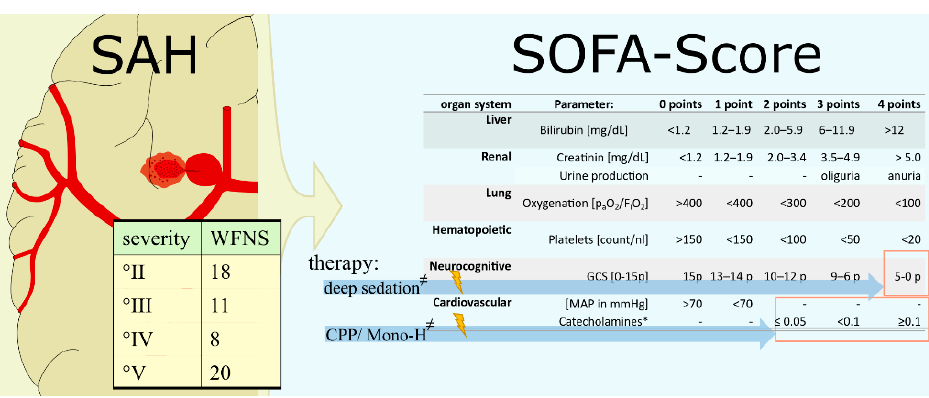
Figure 2. Severity of subarachnoid hemorrhage and influence of sepsis-related organ failure assessment score. Grade of subarachnoid hemorrhage according to the World Federation of Neurosurgery. The possible influences of the corresponding therapy on SOFA score. Abbreviations: CPP, cerebral perfusion pressure; CVS, cerebral vasospasm; dL, deciliters; FiO2, inspiratory oxygen fraction; GCS, Glasgow Coma Scale; MAP, middle arterial pressure; mg, milligram; mmHg, millimeters mercury; Mono-H, therapy strategy of cerebral perfusion protection by raising the mean arterial pressure >90 mmHg; nl, nanoliter, p a O 2 , arterial oxygenation; p, points; SAH, subarachnoid hemorrhage; SOFA, sepsis-related organ failure assessment; WFNS, World Federation of Neurosurgery. * Initial SOFA Score publication lists dobutamine as the first-choice catecholamine. Moreover, this approach has been abandoned in favor of using norepinephrine as the first-choice catecholamine. (cid:54) = Significant impairment of the SOFA score with respect to false positive sepsis detections.